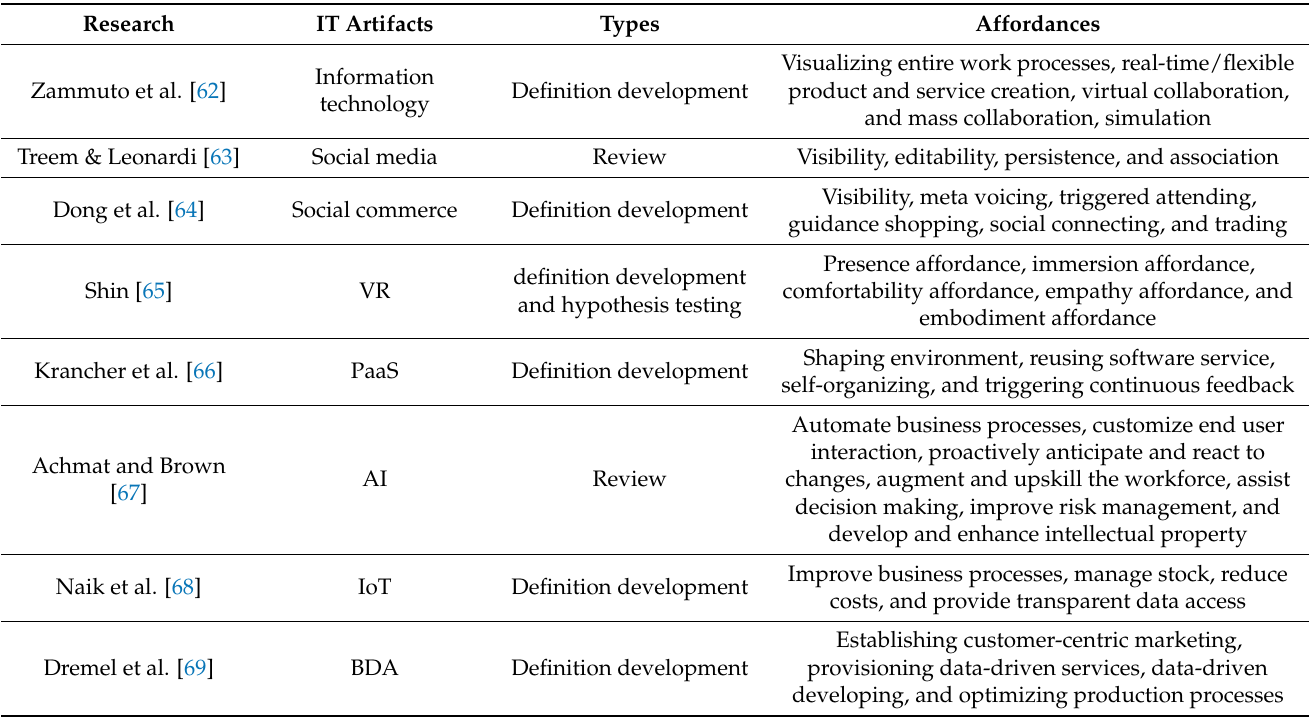
Table 2. Affordances of typical digital